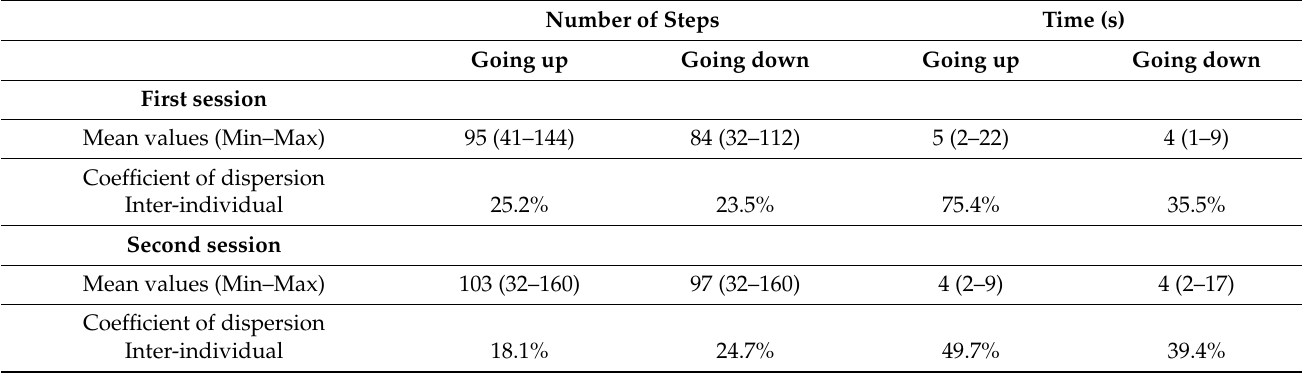
Table 4. Stairs assay compliance values for the first and second baseline acquisition sessions.